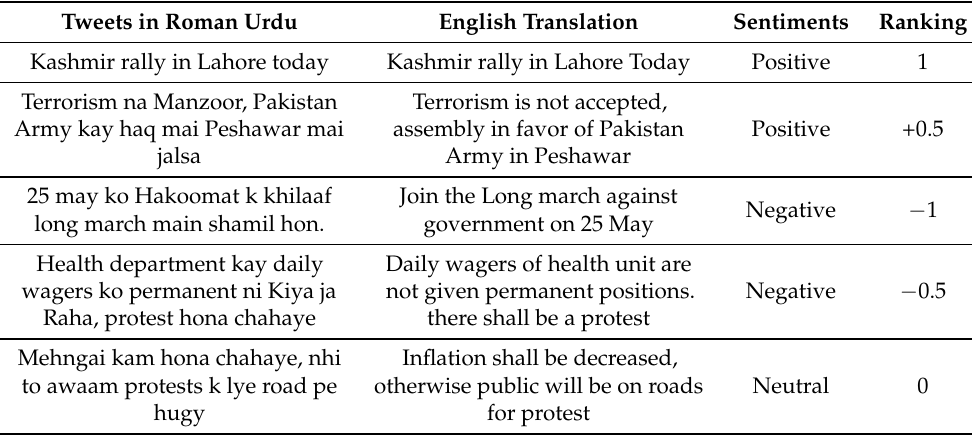
Table 1. Ranking of positive, negative, and neutral tweets. Tweets in Roman Urdu English Translation Sentiments Ranking